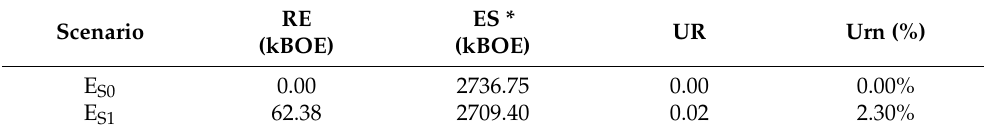
Table 22. Use of RE in energy supply.